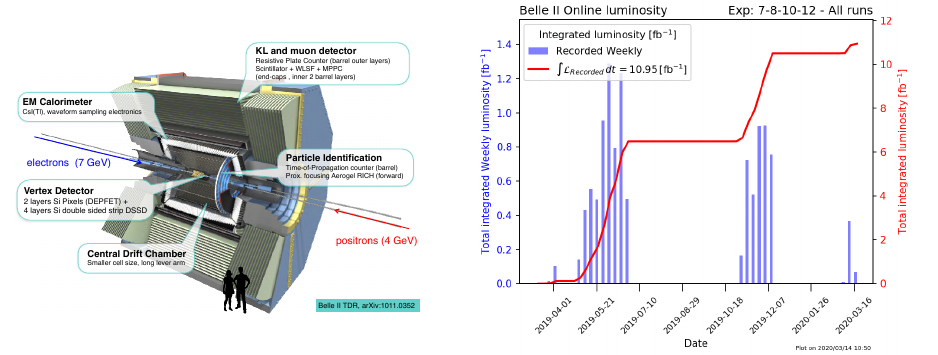
Figure 1. Left: A simple overview of the Belle II detector’s main sub-detector components. Right: Recorded integrated luminosity measured from the online data acquisition system since 2019. Totals are given in weekly intervals and as the cumulative integrated